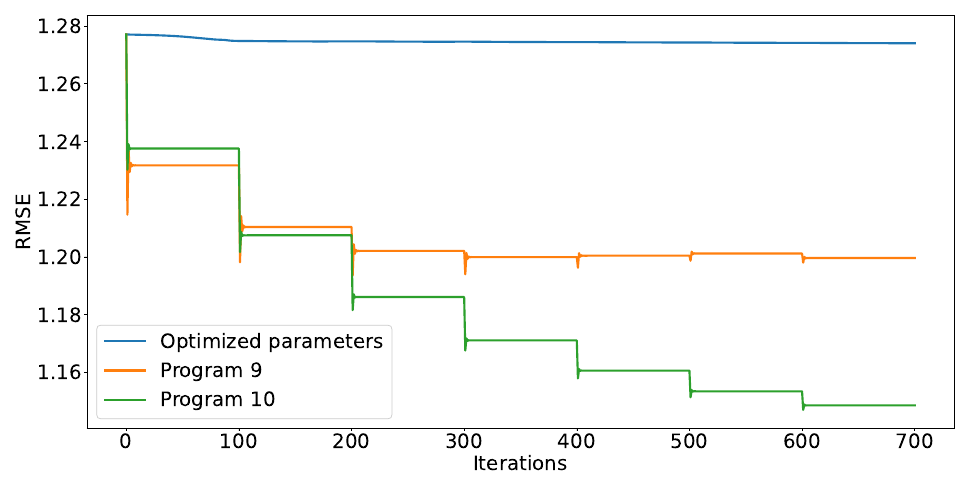
Figure 2. Convergence of the RMSE value using Equations (9) (orange) and (10) (green) compared to the results obtained with optimized parameters 5.1 (blue) using the CoMoDa dataset.